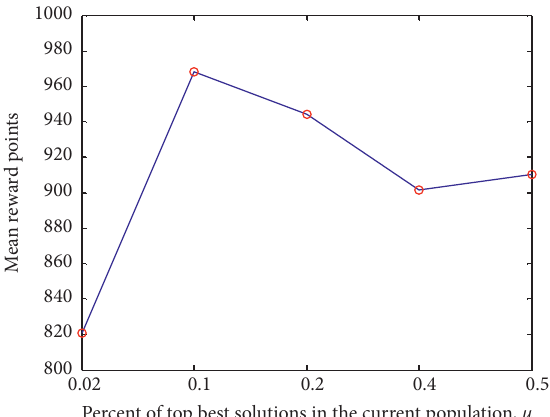
Figure 3: Mean reward points for different percents of top best solutions in the current population ( μ ).